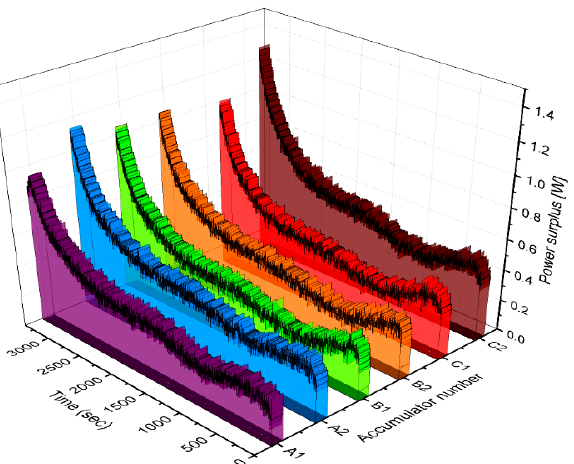
Figure 9. Power surplus: continuous delivered power subtracted from pulsed delivered power (5.8 kHz) at identical discharge rate (1C-rate).